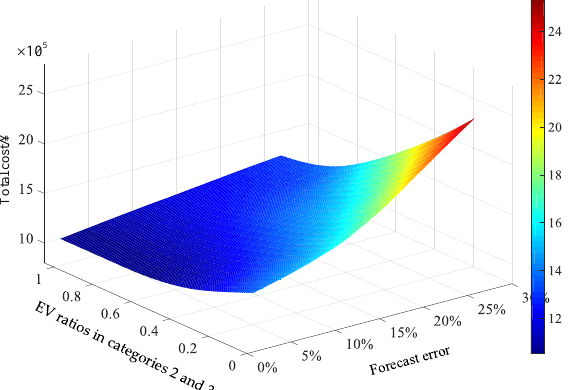
Figure 12. Relationship between total cost and prediction error and proportion of EVs.